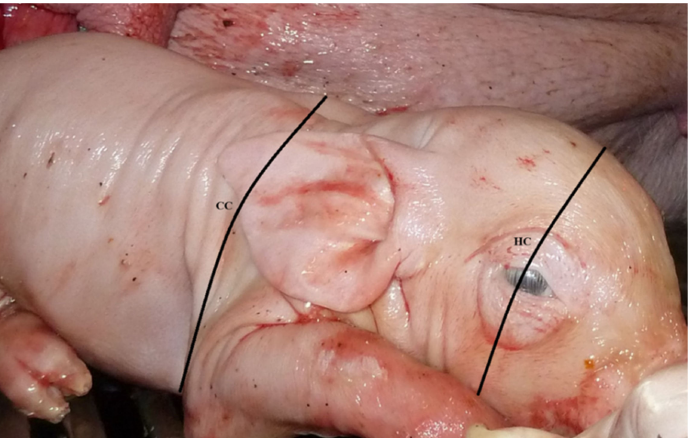
Figure 2. Measuring points of head circumference (HC) and chest circumference (CC) from newborn piglets. Photo copyright by Guy-Pierre Martineau.